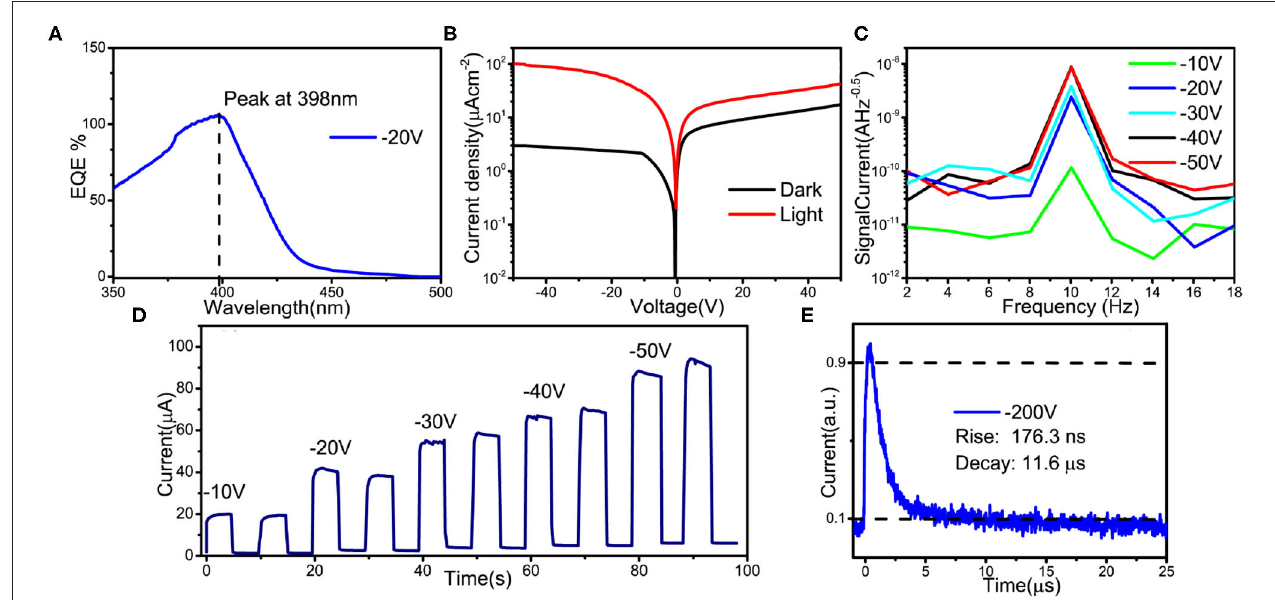
FIGURE 4 | (A) EQE curve under 20 V from 350 to 500nm. (B) Current density vs. Voltage curve. (C) Signal current as a function of frequency under different − voltage bias. (D) Temporal response of the photo-diode under different Voltage. (E) Rise time and decay time of the photo-diode at